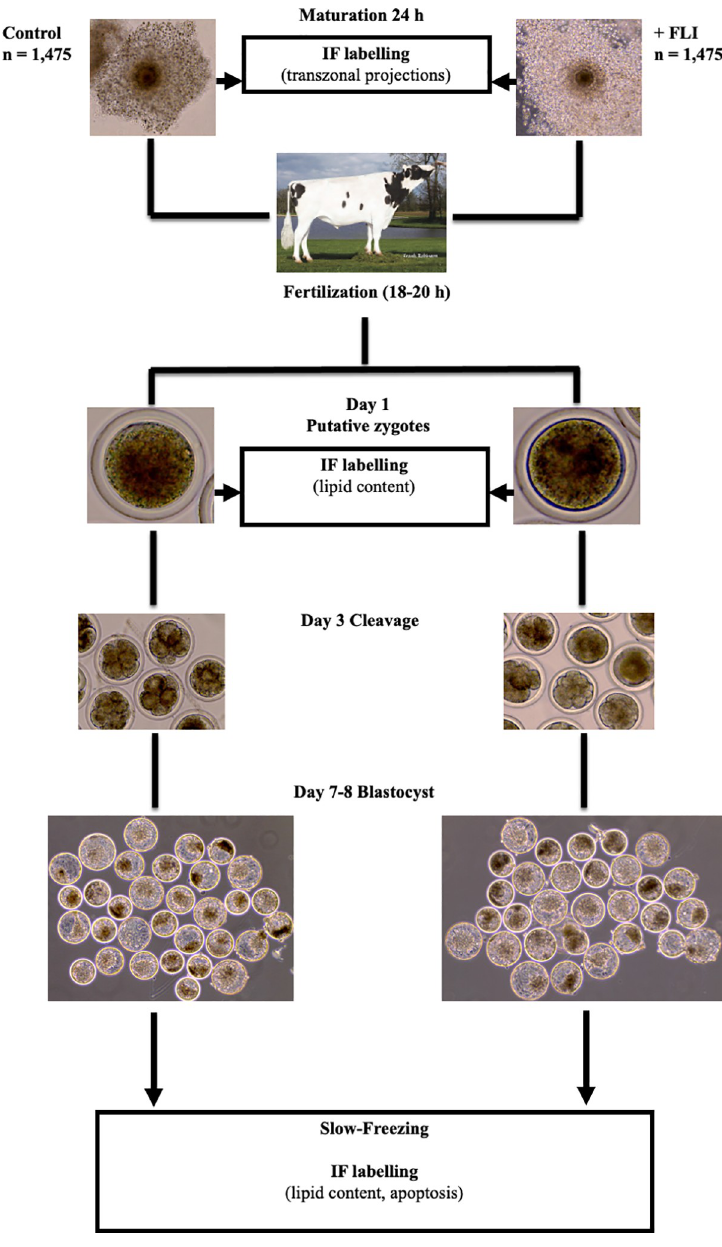
Fig 1. Experimental setup of FLI supplemented to oocyte maturation medium. Cumulus oocyte complexes (COCs) were matured in oocyte maturation medium (OMM) with (n = 1475) or without (n = 1475) FLI. FLI was supplemented at the dosage of FGF2 (40ng/ml), LIF (20ng/ml), and IGF1 (20ng/ml). For analysis of transzonal projections, COCs were collected at 6 h, 12 h, 18 h, 24 h after placement into OMM. At 24 h, maturation stage was recorded. Following fertilization, a subset of putative zygotes (day 1) was collected for lipid content quantification. Cleavage (at least one cellular division) was recorded on day 3 and development to the blastocyst stage was recorded on days 7 and 8. On day 7 or 8, blastocyst stage embryos were either collected for quantification of lipid content or slow frozen, thawed, and subjected to a TUNEL assay to analyze apoptosis. IF = immunofluorescent labeling. https://doi.org/10.1371/journal.pone.0243727.g001 Fertilization proceeded for 18–20 h in a humidified atmosphere of 5% (v/v) CO end of fertilization, putative zygotes (oocytes exposed to sperm) were denuded from cumulus cells by vortexing for five min in 200 μ l HEPES-TALP. Embryos were then washed three times